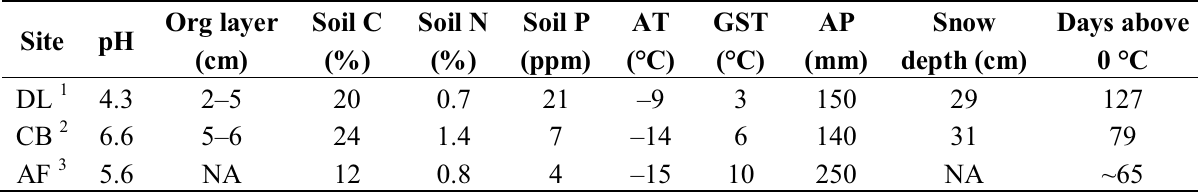
Table 1. Comparison of some soil biochemical and climatic variables including pH, organic layer (org layer) depth, soil carbon and nitrogen, mean annual temperature (AT), mean growing season temperature (GST), average annual precipitation (AP), snow depth, and average number of days above 0 °C for the three sites, Daring Lake (DL), Cambridge Bay (CB) and Alexandra Fjord